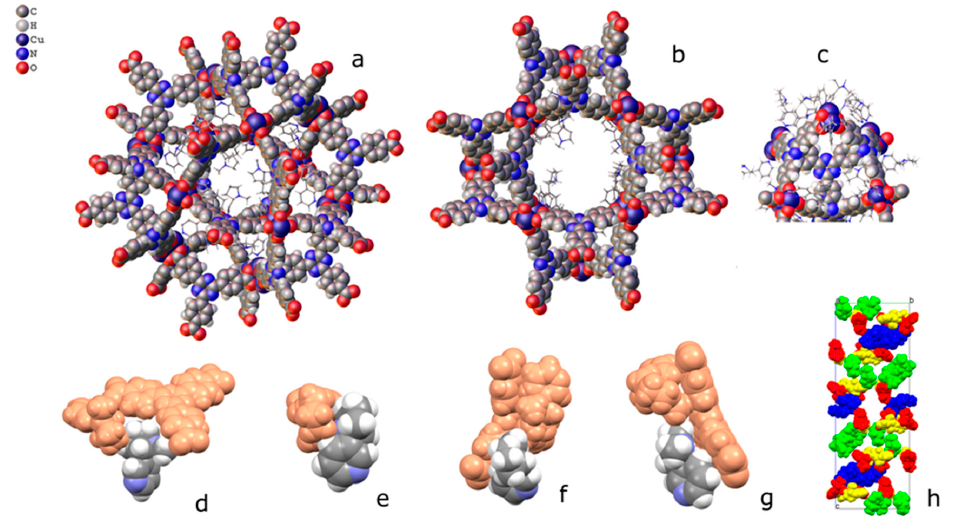
Figure 5. Packing of coordinated nicotine molecules in PCN-6@nicotine. ( a , b ) two orientations of pore A, with coordinated nicotine protruding in the cavity; ( c ) pore B; ( d – g ) contacts of the four coordinated nicotine molecules with other guests and with the MOF skeleton; and ( h ) packing of the four nicotine molecules (evidenced in four colours) inside the structure, with the MOF skeleton removed.